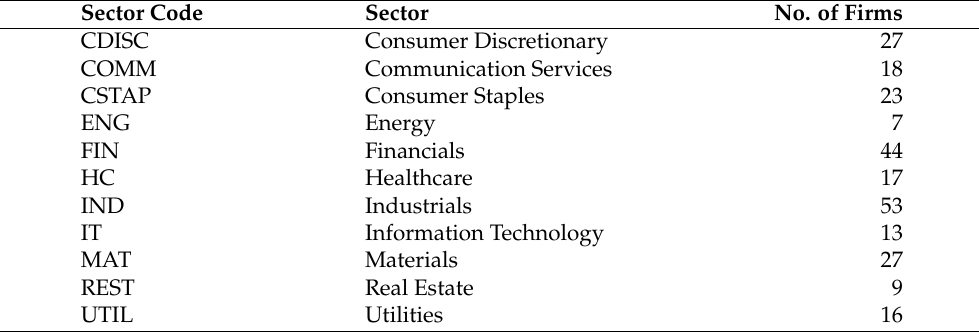
Table A11. Sectors .